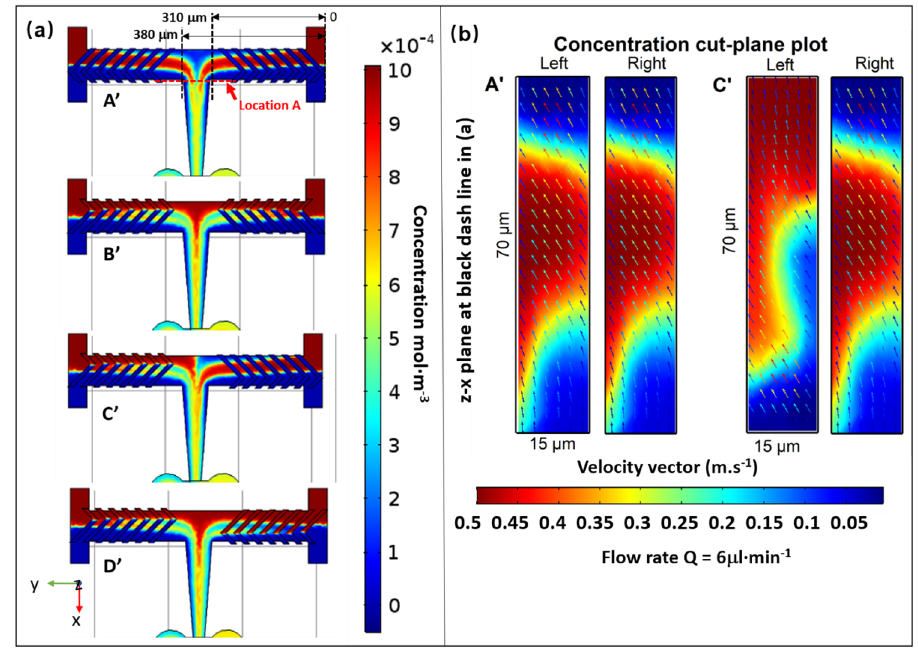
Figure 3. Simulation results along the mixing channel of four SHB designs A’, B’ C’ D’. (a) shows the concentration profiles in the x–y plane at z = 7.5 µm (middle of the channel), the two black dashed lines indicate the locations at the end of premixing after passing through half cycle of the grooves on each side (distance of 310 µm and 380 µm from the entrance at the right), while the red dashed line indicates the location where the combined solutions change the flow direction to x . (b) is the slice concentration profile projected onto x–z plane located at the black dashed lines at 310 and 380 µm from the right channel labelled as “left” and “right”, respectively. The concentration profile shares the same color bar with (a) . Velocity vectors were plotted as colored arrows with the color bar representing the velocity (m·s −1 ). The simulations were performed with